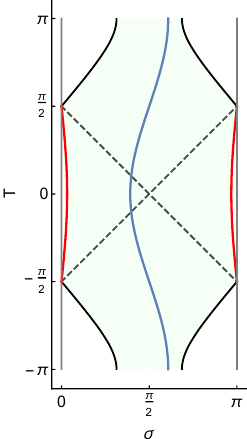
Figure 2. The solution of JT gravity. The light green region is physical in which Φ + φ 0 ≥ 0 . Red curves are two AdS boundaries with T ∈ [ − π/ 2 , π/ 2] . The dashed lines are horizon. Blue curve is the geodesic of EOW